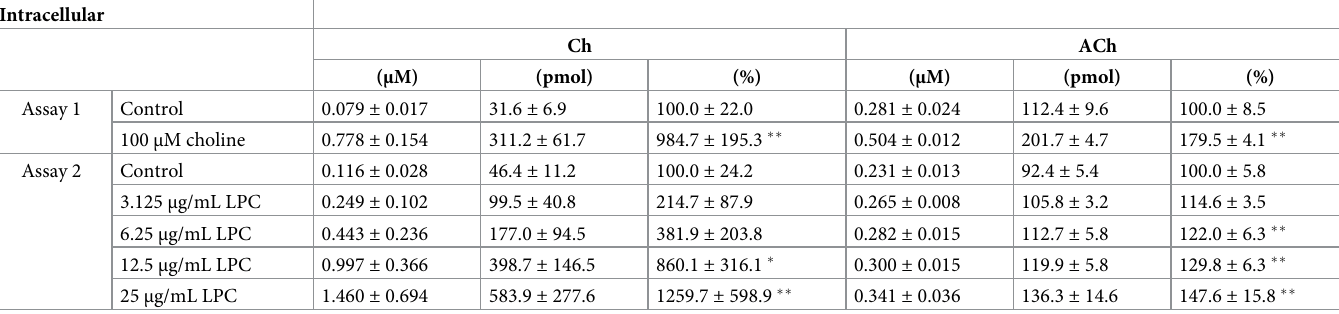
Table 2. Changes in the choline and acetylcholine levels in LA-N-2 cells after treatment with choline and lysophosphatidylcholine that have a Ch moiety. Intracellular